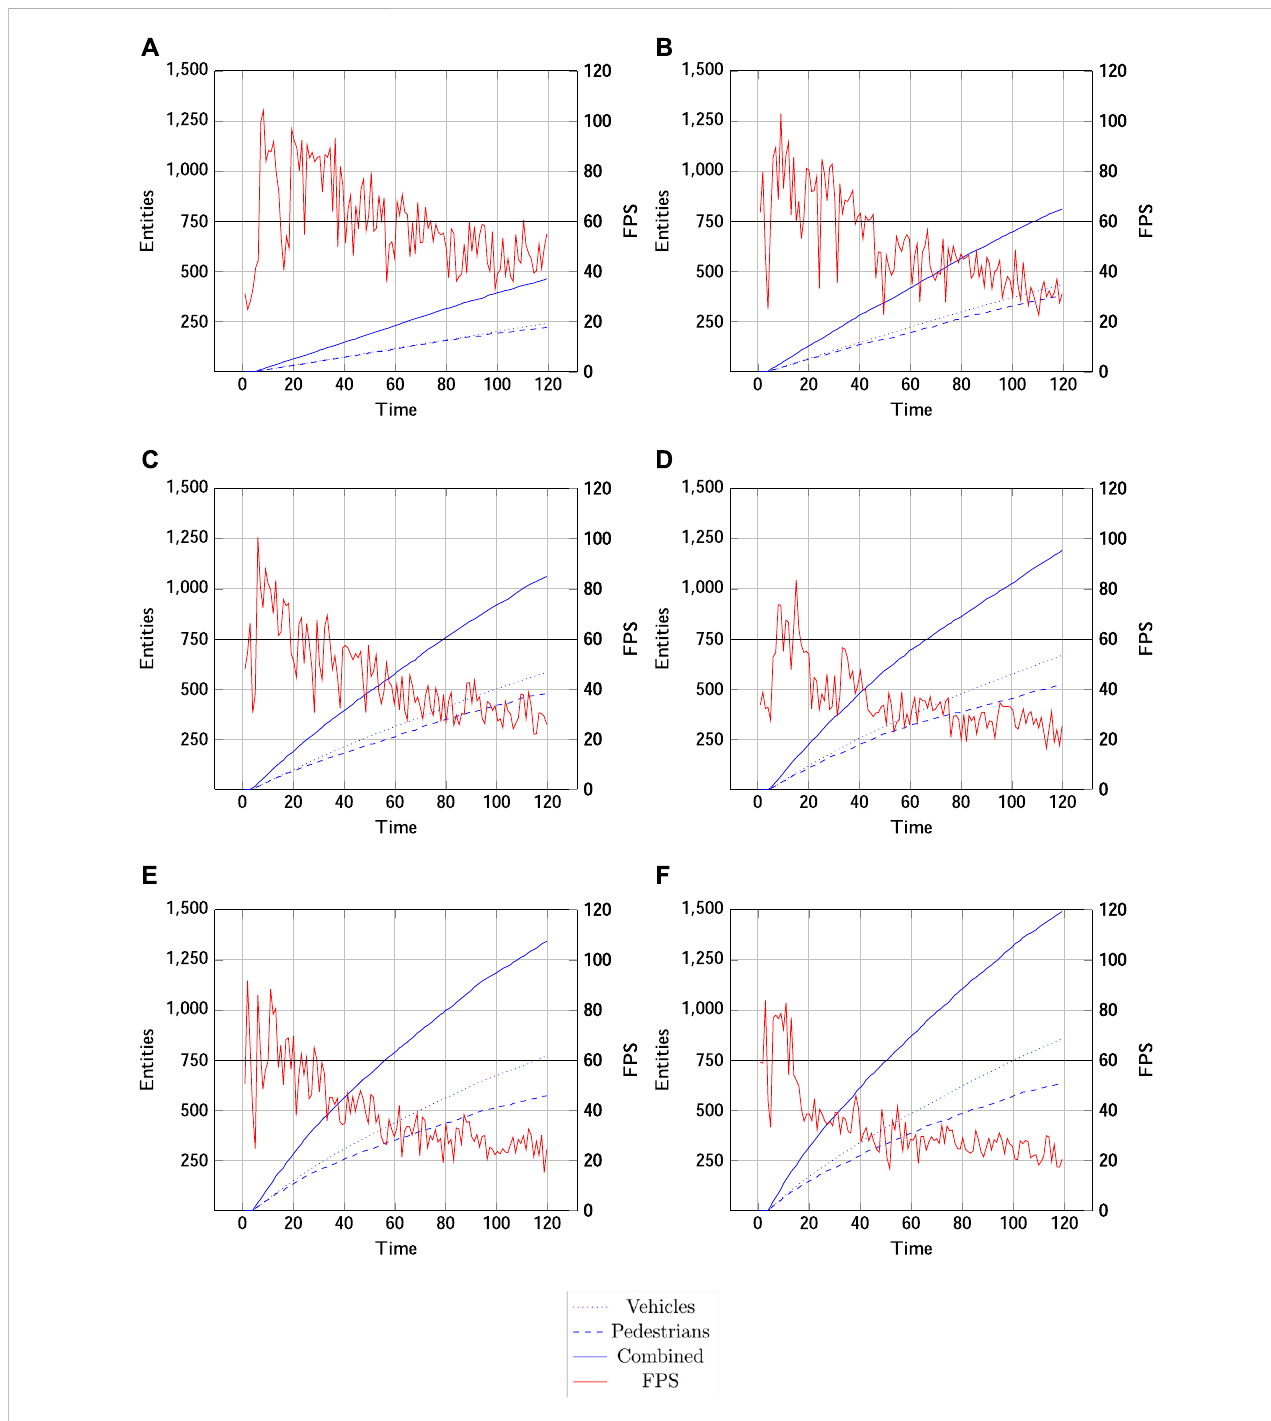
FIGURE 9 The results of the performance test. The frame rate is visualized in red, and the number of entities is visualized in blue. The time is given in seconds from the start of the visualization. The following captions provide the spawn rate for pedestrians and cars for each fi gure. (A) : Pedestrians: 5/s, Vehicles: 5/s, (B) : Pedestrians: 10/s, Vehicles: 10/s, (C) : Pedestrians: 15/s, Vehicles: 15/s, (D) : Pedestrians: 20/s, Vehicles: 20/s, (E) : Pedestrians: 25/s, Vehicles: